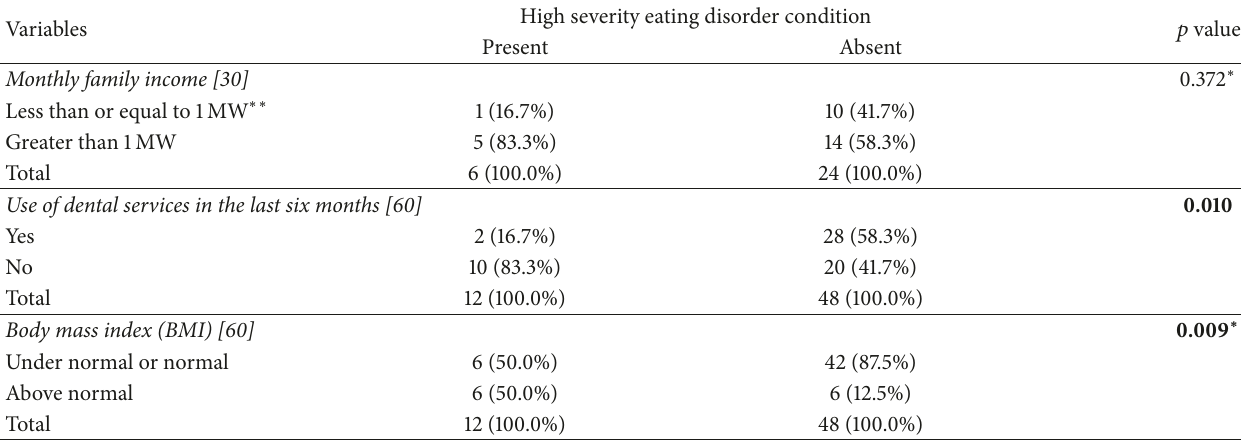
Table 4: Relationship between high severity eating disorder condition, sociodemographic variables, and physical aspects. Variables